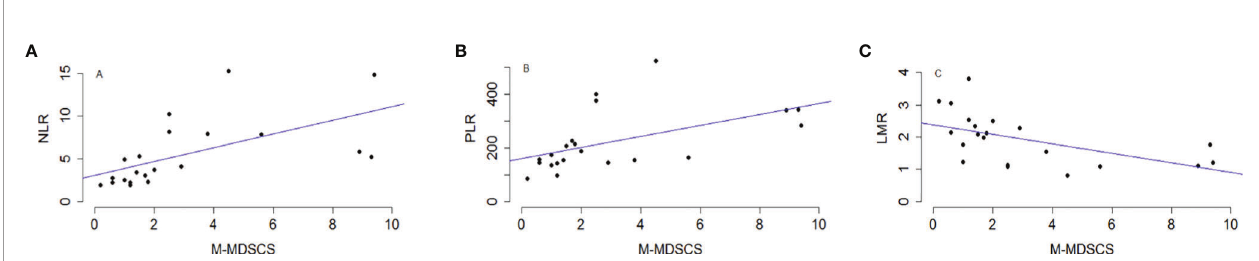
FIGURE 5 | Scatter plots with regression lines as regards the correlation between M-MDSCs and SIIs, NLR (A) , PLR (B) , and LMR (C) . M-MDSC, monocytic myeloid-derived suppressive-like cell; SIIs, systemic in fl ammation indicators; NLR, neutrophil-to-lymphocyte ratio; PLR, platelet-to-lymphocyte ratio; LMR, lymphocyte-to-monocyte